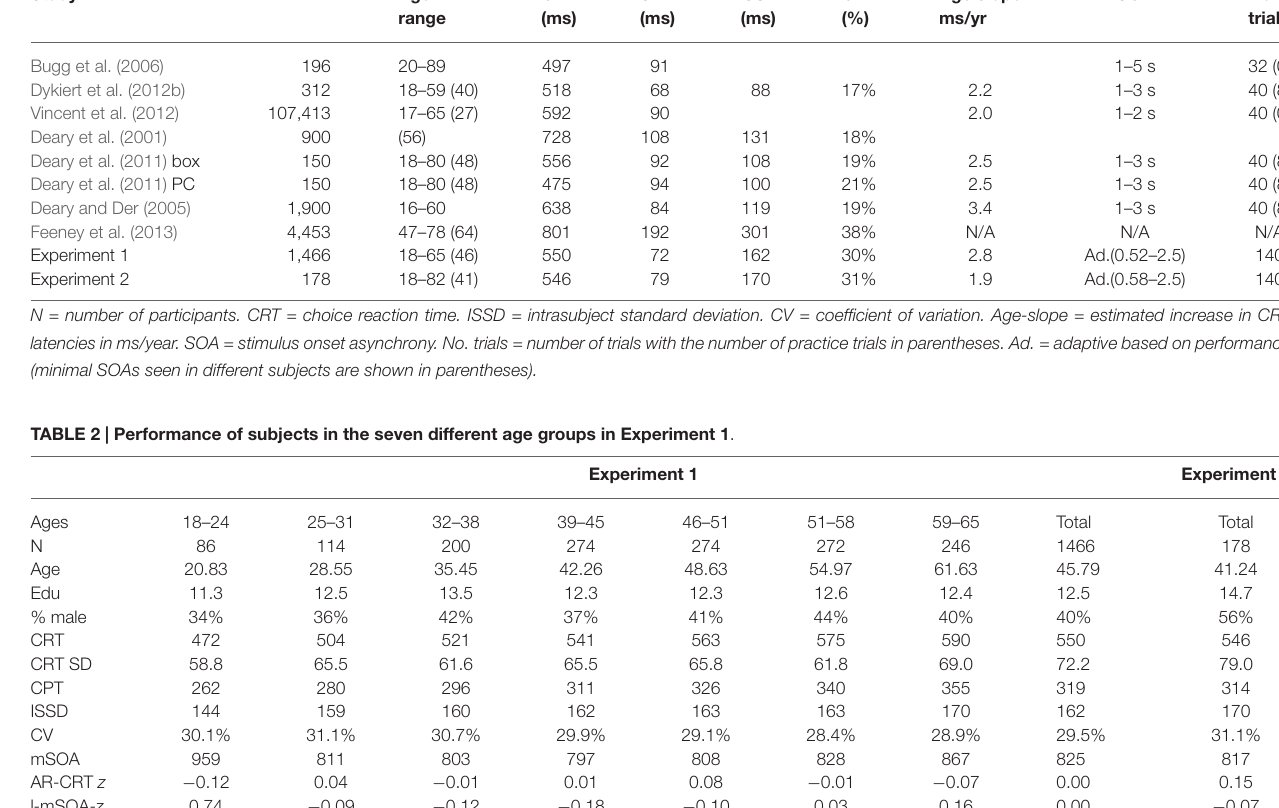
TABLE 1 | Large-scale studies of age-related changes in visual choice reaction time . Study